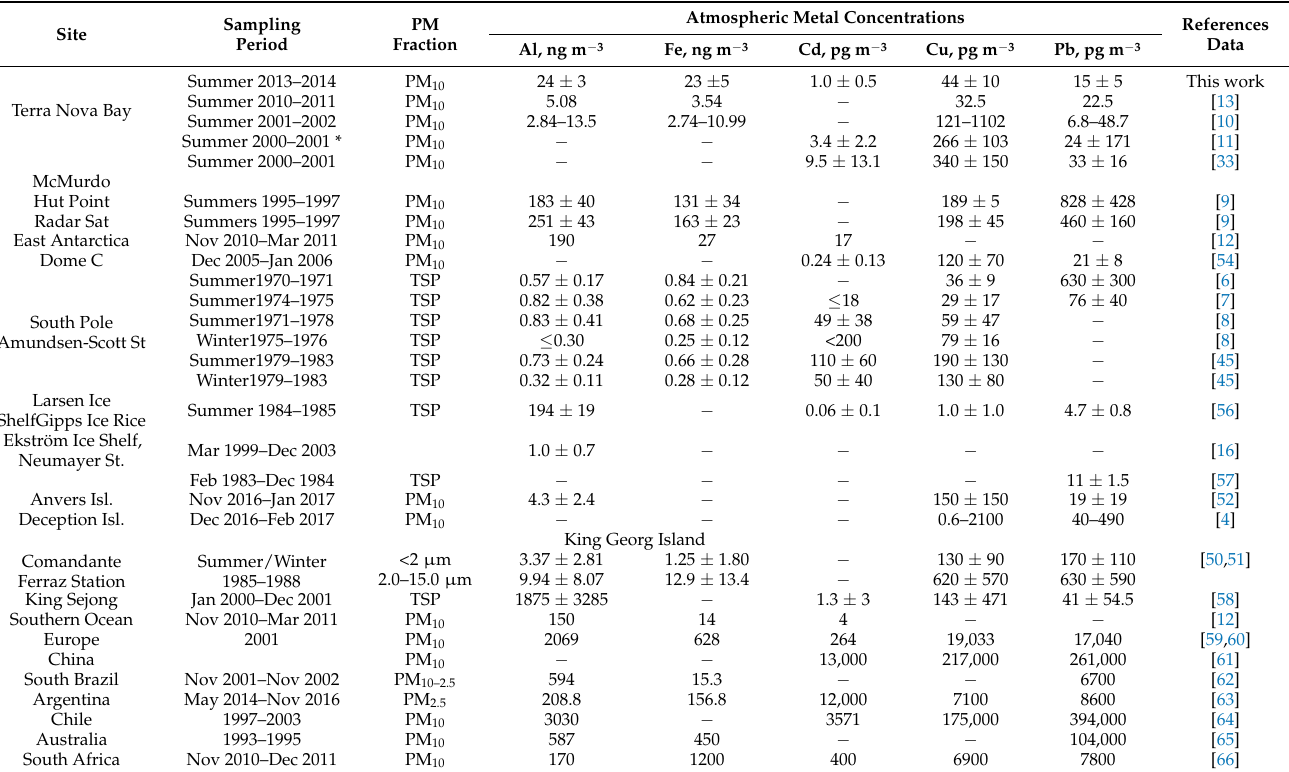
Table 3. Summary of atmospheric metal (Al, Fe, Cd, Cu, and Pb) concentrations measured in various Antarctic locations and in other areas worldwide.